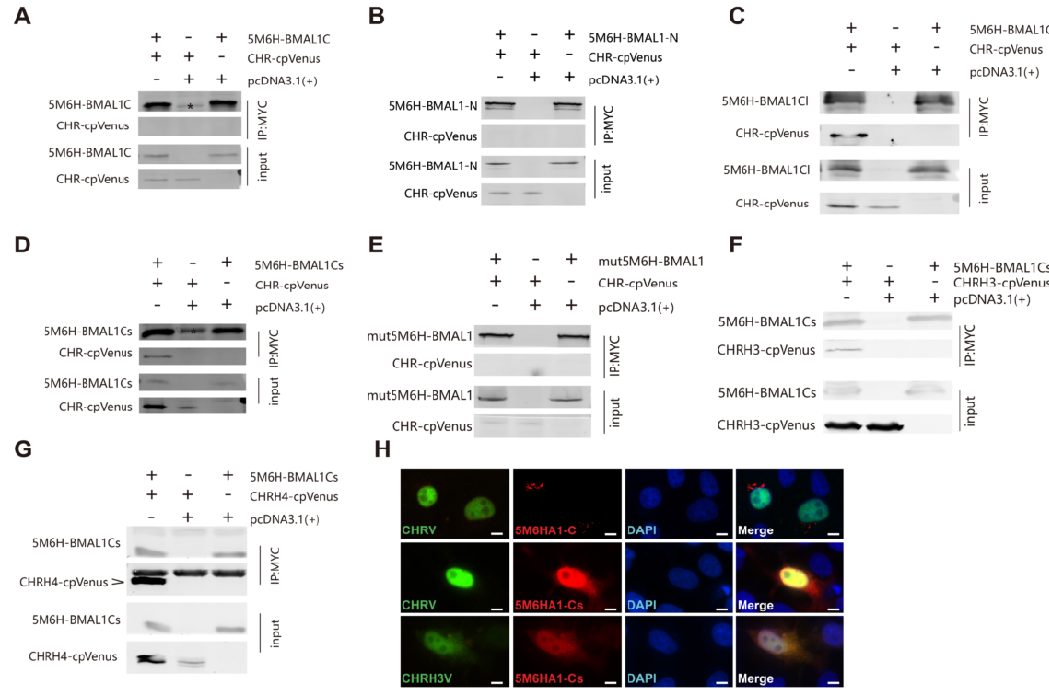
Figure 4. Co-IP and IF (immunofluorescence) suggest that the C-terminus rather than other regions of BMAL1 interacts with CHR. ( A ) The unique region of BMAL1 reported by previous study (14), from 514 to 594, could not pull down CHR in HEK293T cell extracts. ( B ) The N-terminus of BMAL1 is not able to be co-immunoprecipitated with full-length CHR either when both were co-transfected in HEK293T cells. ( C ) However, a construct of the intact C-terminus of BMAL (from 490 to 626) named as BMAL1-Clong (BMAL1Cl) is able to precipitate full-length CHR in HEK293T cells. ( D ) BMAL1-C short (BMAL1Cs, from 579 to 626), the distal C-terminal domain of BMAL1, is sufficient to immunoprecipitateCHR from HEK293T cell extracts when both BMAL1Cs and CHR were co-transfected. ( E ) Via disruption of the IxxLL motif in the TAD domain at BMAL1 ′ s distal C-terminus via Leucine-to-Alanine mutations at 606 and 607 sites, full-length CHR was not able to be precipitated using anti-Myc antibodies that successfully pulled down 5M6H tagged BMAL1 proteins. ( F ) BMAL1Cs could weakly precipitate with the minimum repressing domain of CHR (CHRH3) using anti-Myc antibodies, which agrees to the luciferase reporter assays. ( G ) In comparison to CHRH3, more CHRH4 was precipitated by BMAL1Cs. ( H ) In line with these IP results, immunofluorescence (IF) confirmed the interactions between BMAL1-Cs and full-length CHR and the minimum repressor CHRH3, while CHR failed to co-localize with BMAL1-C (514~594). Bar =10 μ m. Note that an unspecific band appeared when the short forms of BMAL1 C-terminus was used in the IP assays. Asterisk marks in panels ( A ) and ( D ) designate unspecific precipitated products using anti-myc antibodies that ran at the same position with 5M6H-BMAL1C or short version of BMAL1C. A few dots in panel C appeared due to contamination during the immunoblotting process. At least two independent experiments were carried out as repeats.